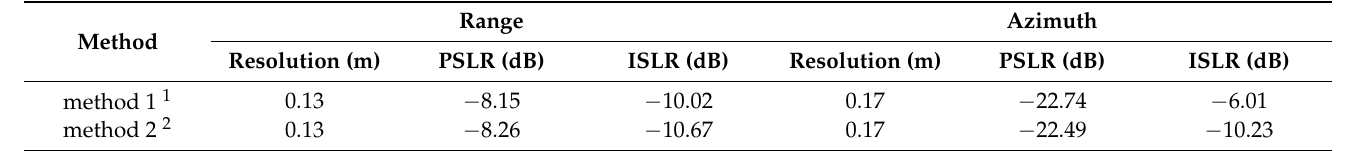
Table 3. Point target comparison results of different